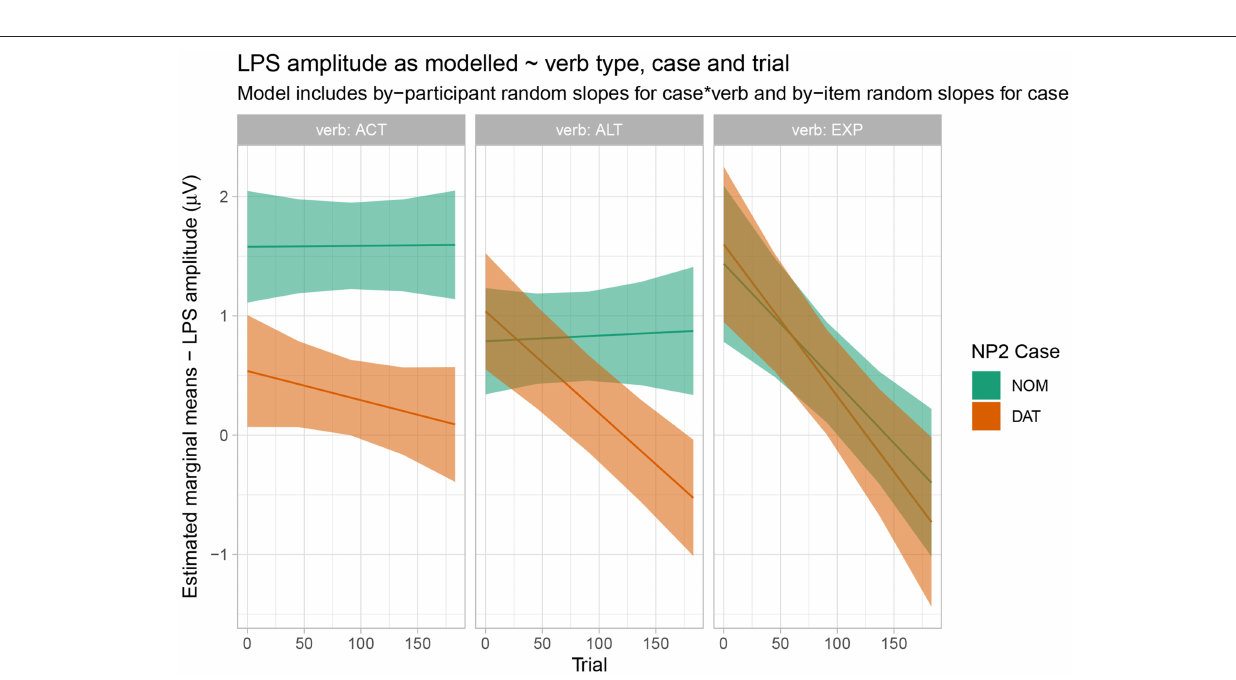
as posited in Bornkessel-Schlesewsky and Schlesewsky (2019), there is evidence to suggest that the same holds for N400 effects in language. From this perspective, we would expect to